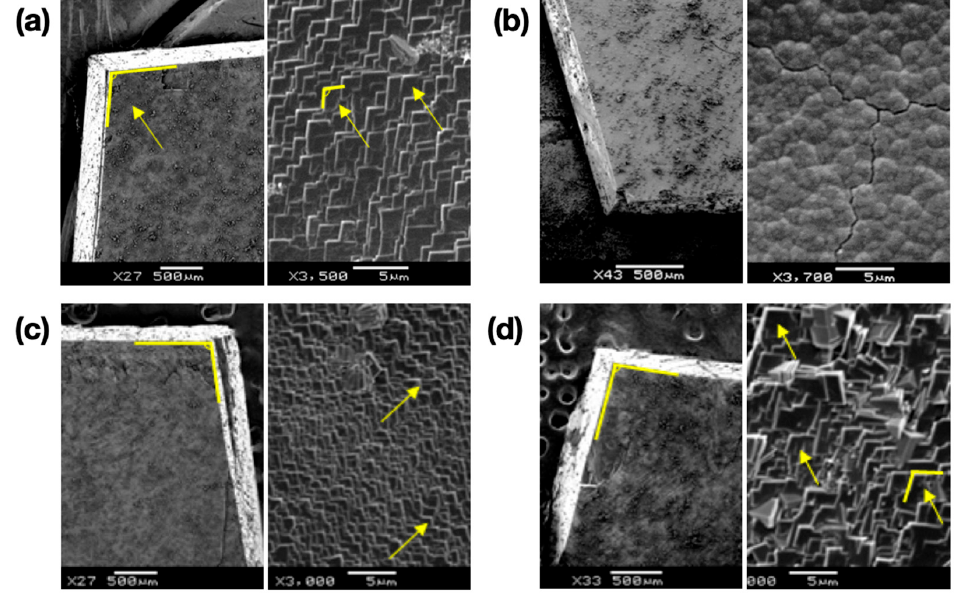
Figure 4. SEM images of the coating layers formed via ACC on single crystals of calcite (top down view) after 90 min with 0.04 mM PAA ( a ); 0.4 mM PAA ( b ); 0.04 mM PEI ( c ); 0.4 mM PEI ( d ).